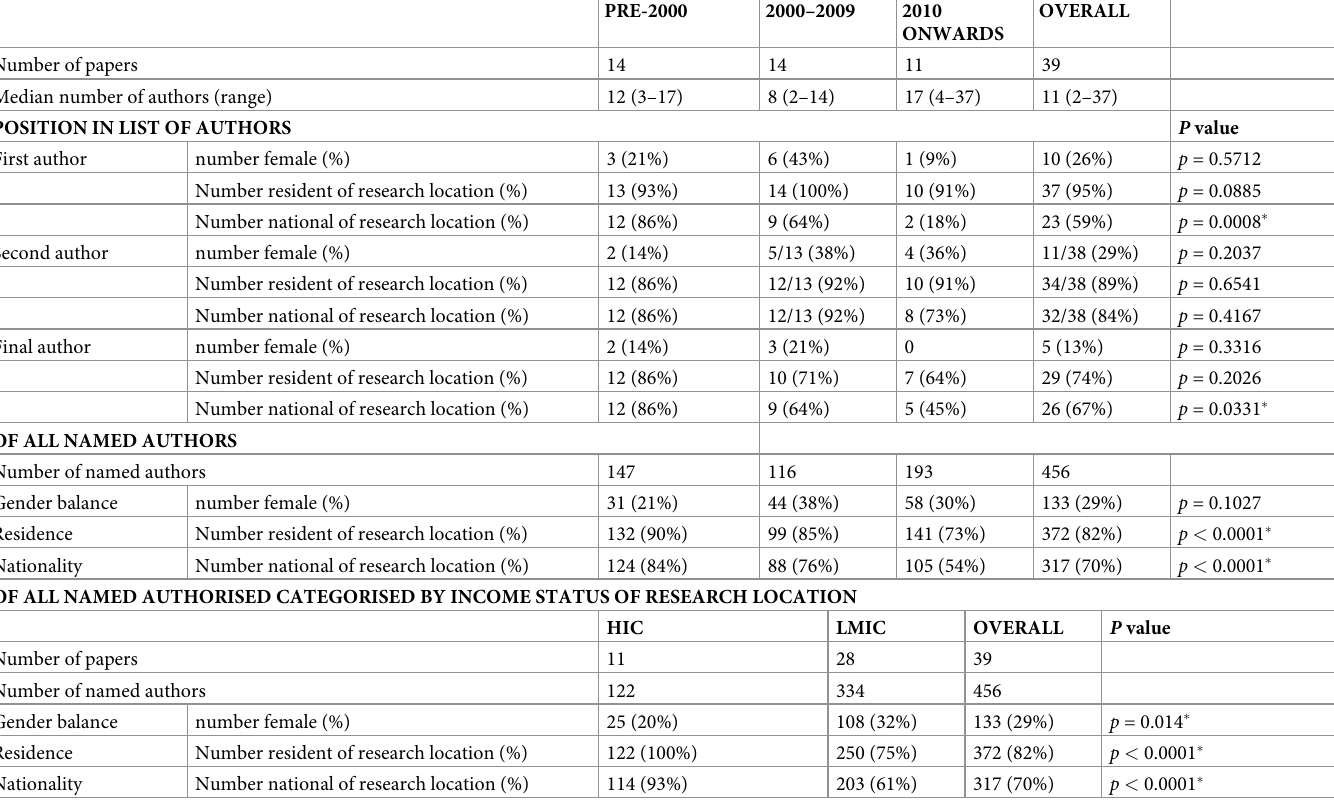
Table 4. Researcher data summarising the number, gender, country of residence, and nationality of named authors on the primary manuscript of HIV-associated cryptococcal meningitis clinical